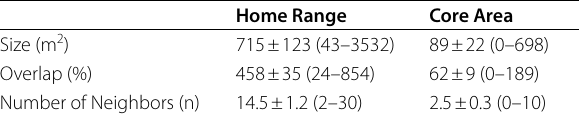
Table 7 Space use metrics on site